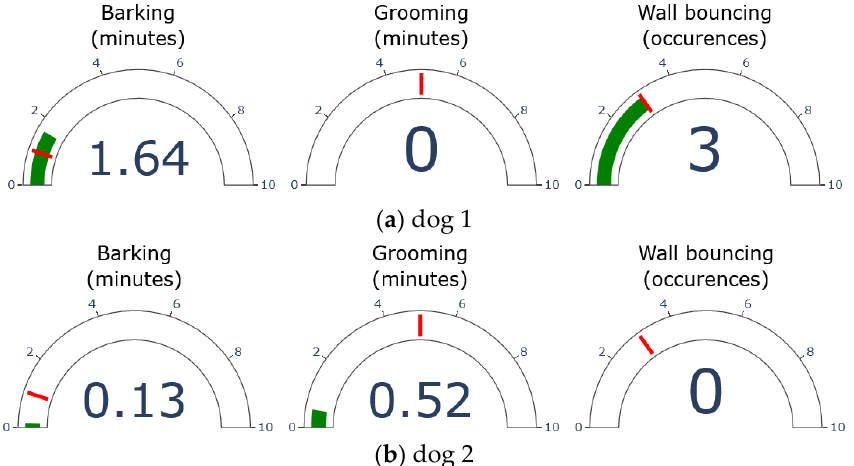
Figure 7. Gauge chart visualization results for monitoring of dog’s poor-welfare indicators: ( a ) example of scenario with dog 1; ( b ) example of scenario with dog 2.